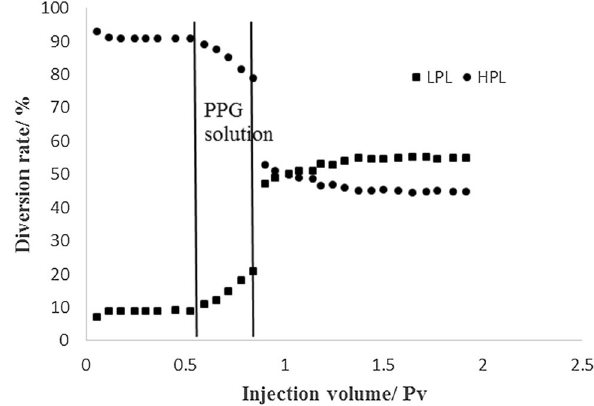
Fig. 1 The result of plugging properties of PPG in the double parallel sandstone